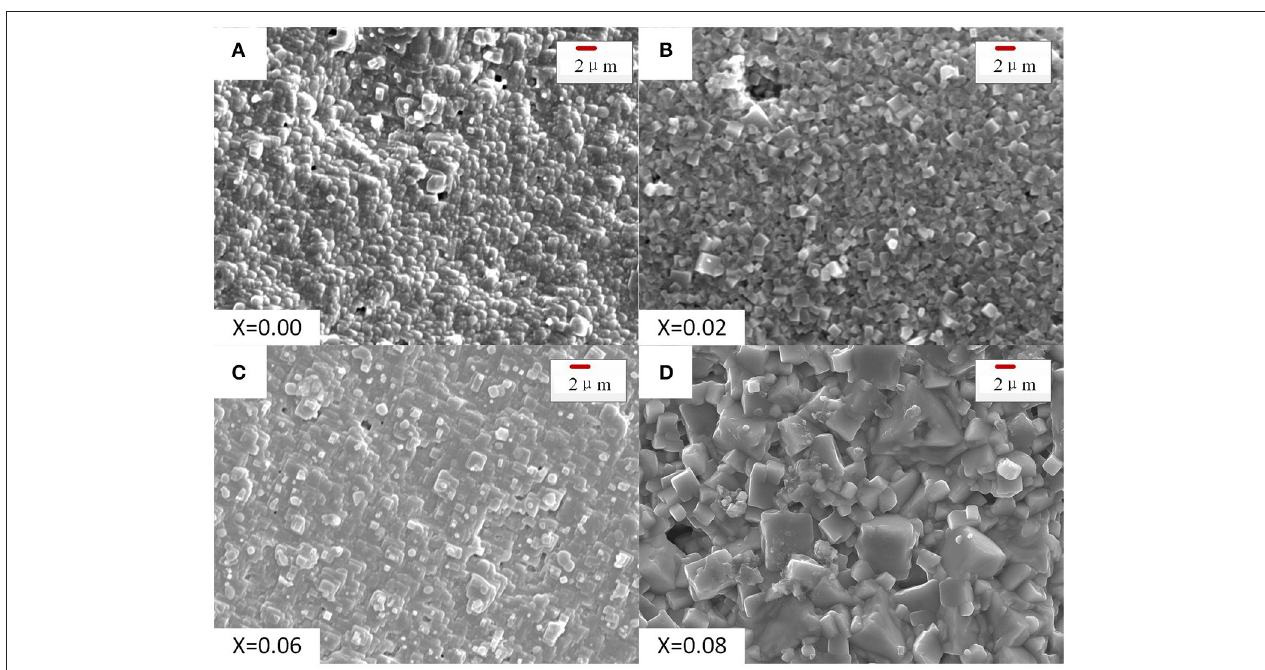
Frontiers in Materials |